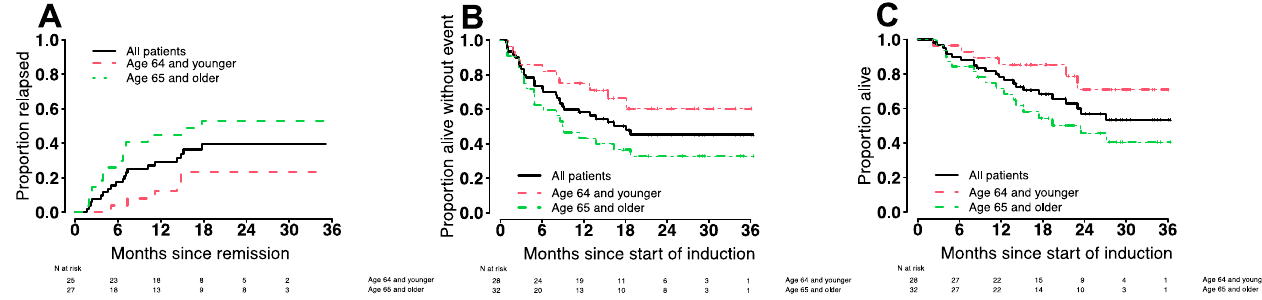
Figure 1. Estimates of ( A ) cumulative incidence of relapse, ( B ) event-free survival, and ( C ) overall survival for the 60 patients who received CLAG-M/GO3 as well as, separately, the 28 patients age <65 years and the 32 patients age ≥ 65 years in this cohort.